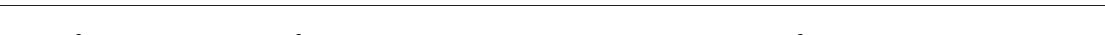
Fig. 6 E. coli elevates [Ca 2+ ] i in M1 and M2 and Ca 2+ is required for LOX translocation. a Measurement of [Ca 2+ ] i . Fura-2/AM-loaded M1 or M2